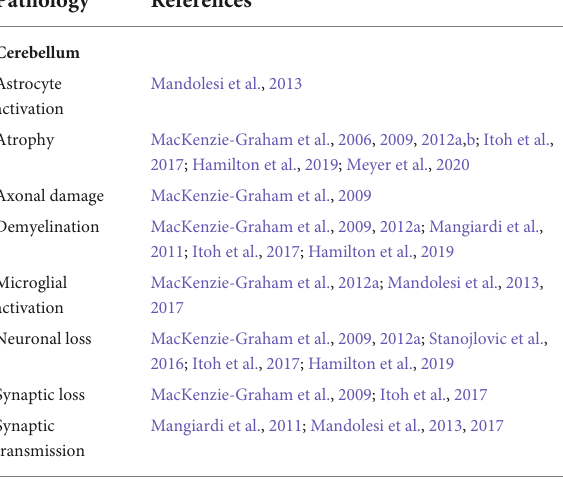
TABLE 5 Pathologies in the cerebellum in EAE.